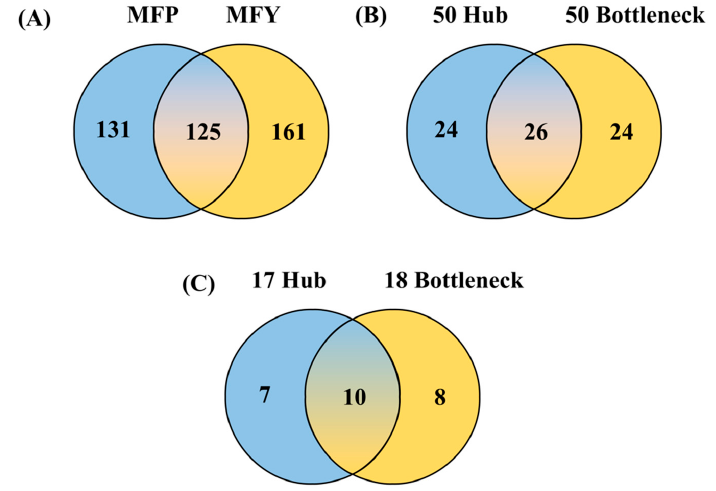
Figure 1. Venn diagram showing the hub and bottleneck genes: ( A ) QTL genes of milk fat percentage (256) and milk fat yield (286), ( B ) genes of top 50 hub and bottleneck genes, ( C ) genes of 17 hub and 18 bottleneck differentially expressed genes. MFP = milk fat percentage, MFY = milk fat yield. A total of 70 genes were found to be upregulated and 52 genes downregulated in the Jersey breed in comparison with the Kashmiri breed. Differentially expressed transcripts (DETs) were also explored for fat QTL genes (Supplementary File 2). The volcano plots of differentially expressed genes (DEGs) and DETs depicting the distribution of upregulated and downregulated genes are shown in Figure 2.